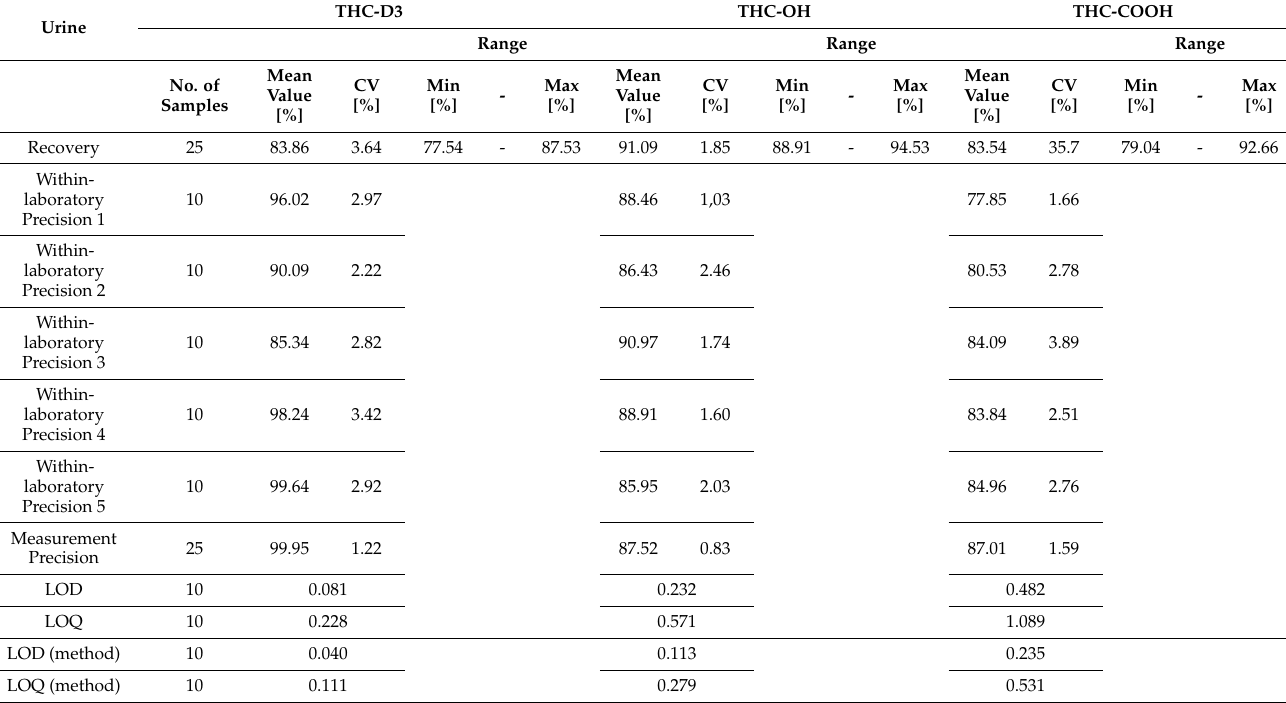
Table 2. Results of Method Validation for Cannabinoid Determination from